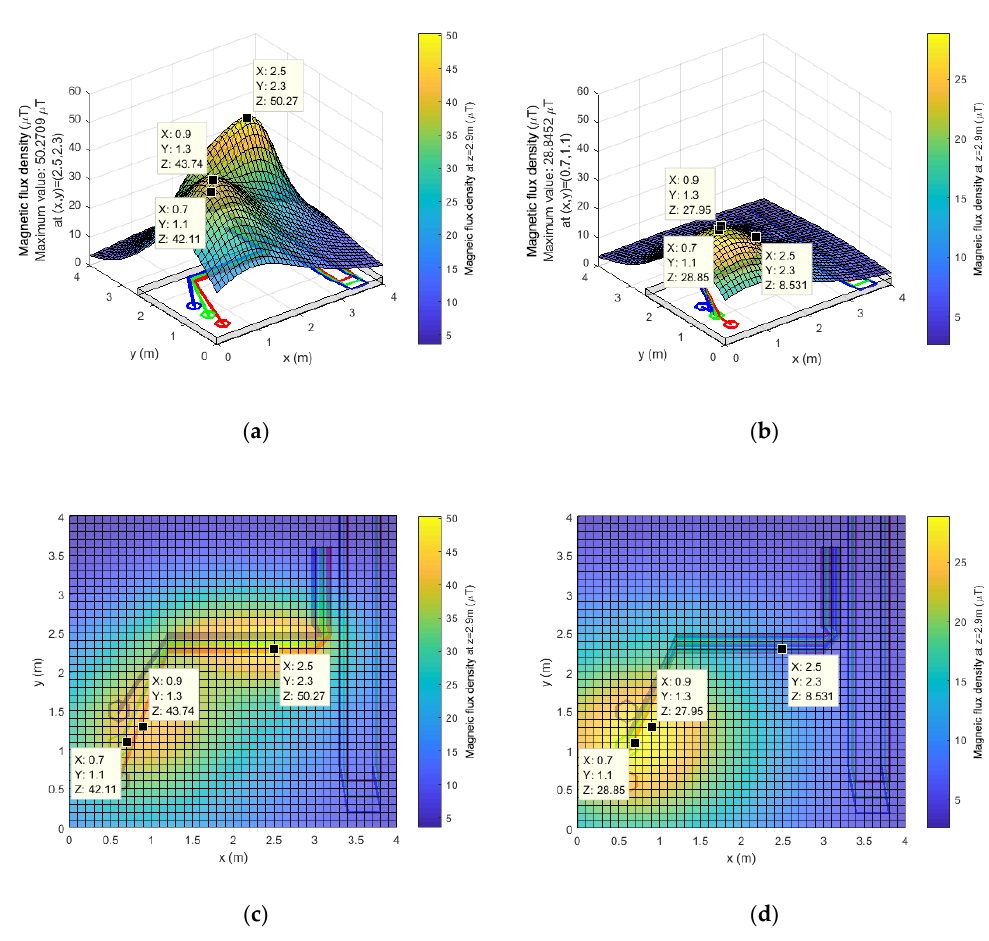
Figure 12. MFD on the upper floor in 3D using ( a ) the original layout and ( b ) the proposed alternative. MFD on the upper floor in 2D using ( c ) the original layout and ( d ) the proposed alternative.